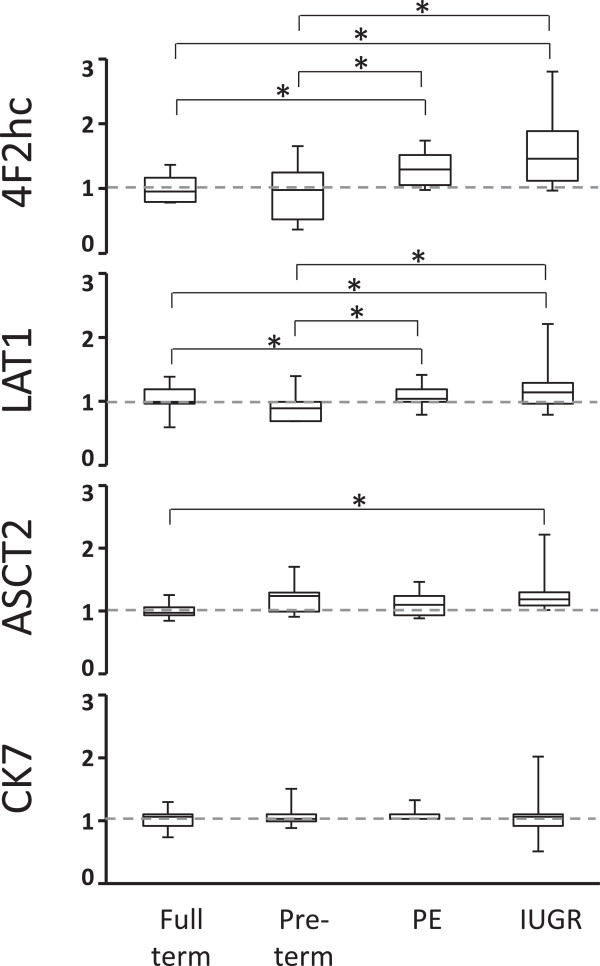
Amino Acid Transporter protein levels in placenta microvillous syncytiotrophoblasts. Protein levels were estimated by blind scoring of IHC-stained formaldehyde fixed samples from the 4 different pregnancy conditions (n = 10 each, * p < 0.05). Data is presented in box and whisker format to define minimum and maximun values (capped bars), 2nd and 3rd quartile (box top and bottom) and median (line through box). Data was normalized to full term controls (mean set to 1, grey dashed line).